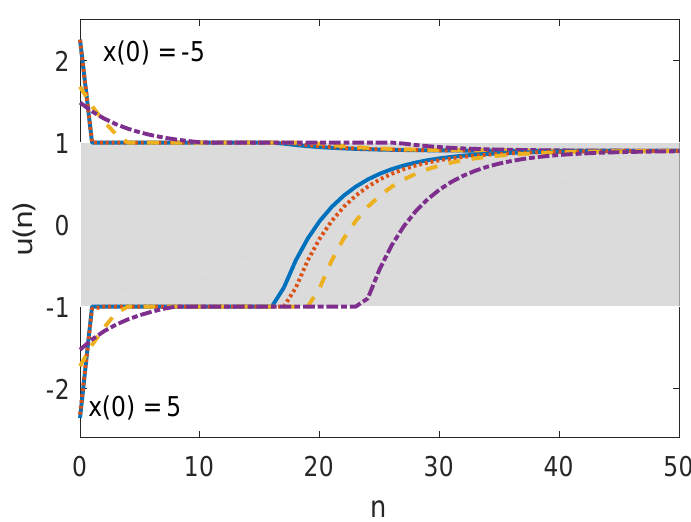
Figure 1. Closed-loop input trajectories of EMPC of Equation (10) with c 1 = 10 4 and c 2 = 10 2 (solid), c 2 = 10 3 (dotted), c 2 = 10 4 (dashed), c 2 = 10 5 (dash dotted), respectively. Shaded area depicts the input target zone. The upper and lower part correspond to initial state x ( 0 ) = − 5 and x ( 0 ) = 5, respectively.